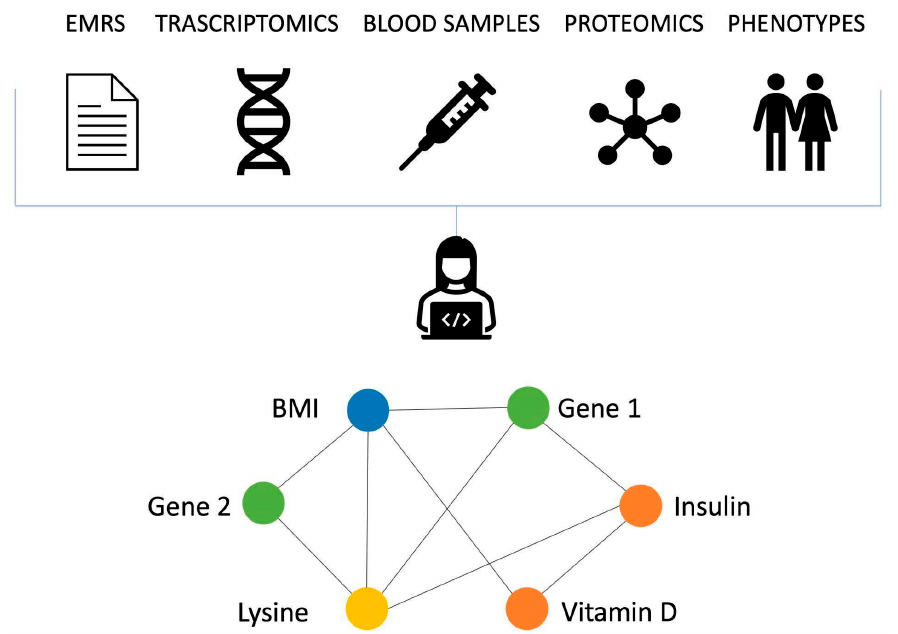
Figure 1. Networks of biomarkers showcase the underlying relationships between biomarkers of different natures. Data gathered from different sources (such as DNA sequencing, blood samples and electronic medical records) can be studied together as a whole system to shed light onto the molecular mechanism of a disease and help the diagnosis process. Here, biomarkers obtained by the same process are shown with the same colors. Biomarkers of different natures can be positively or negatively correlated.